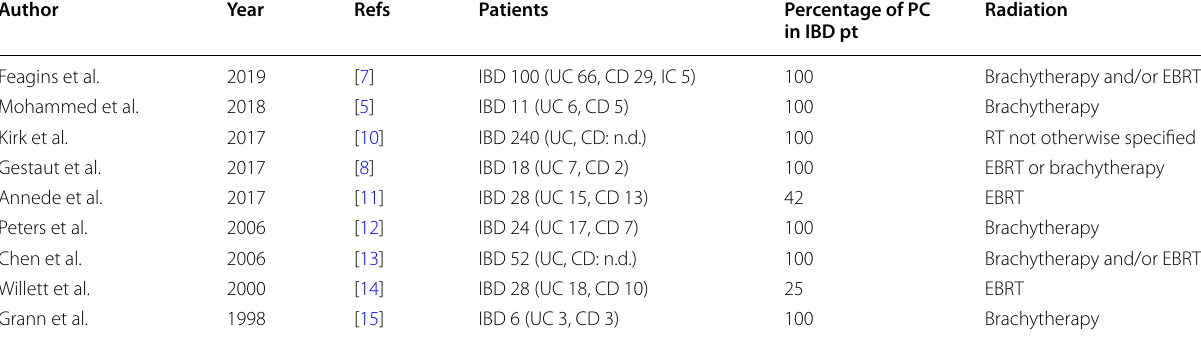
Table 1 Summary of studies assessing radiotherapy for prostate cancer in IBD patients